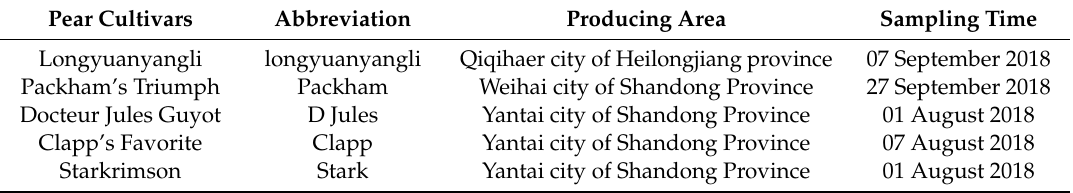
Table 1. The cultivars, abbreviation, producing area and sampling time of 5 pears. Pear Cultivars Abbreviation Producing Area Sampling Time